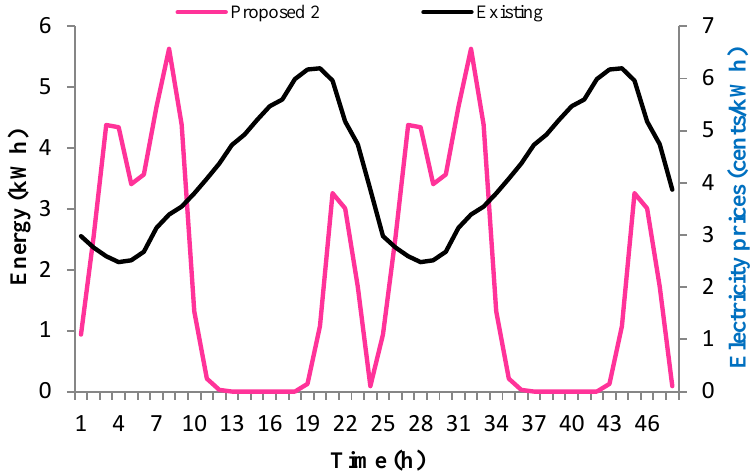
Figure 12. Comparison of energy and cost saving between the proposed 2 and existing scenarios over